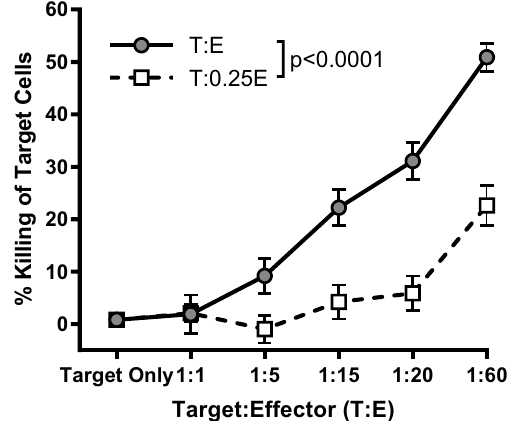
Figure 3. A four-fold reduction in the number of transgene-specific CD8 + T cells significantly abrogated cytotoxicity. C57BL/6 mice were vaccinated intramuscularly with 1 × 10 8 IU of an adenovirus expressing human dopachrome tautomerase (hDCT). Ten days later, splenocytes were harvested and used for the negative magnetic selection of CD8 + T cells. These T cells were co-cultured with various ratios of B16-F10 melanoma cells that had been pre-treated for 24 h with recombinant interferon-gamma to upregulate the expression of major histocompatibility complex molecules to facilitate antigen presentation. In parallel, a second set